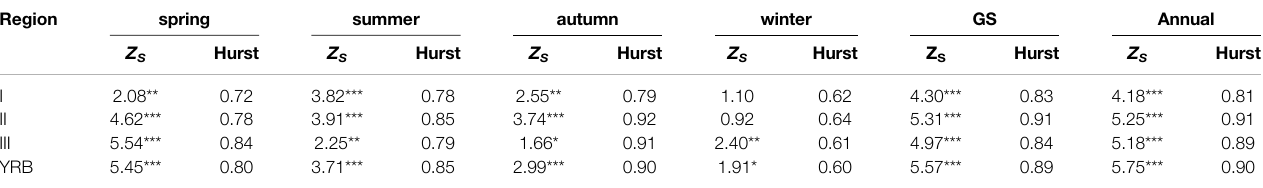
TABLE 3 | Trends and Hurst index of NDVI in the Yellow River basin and three sub-regions. Region spring summer autumn winter GS Annual Hurst Hurst Z S Z S